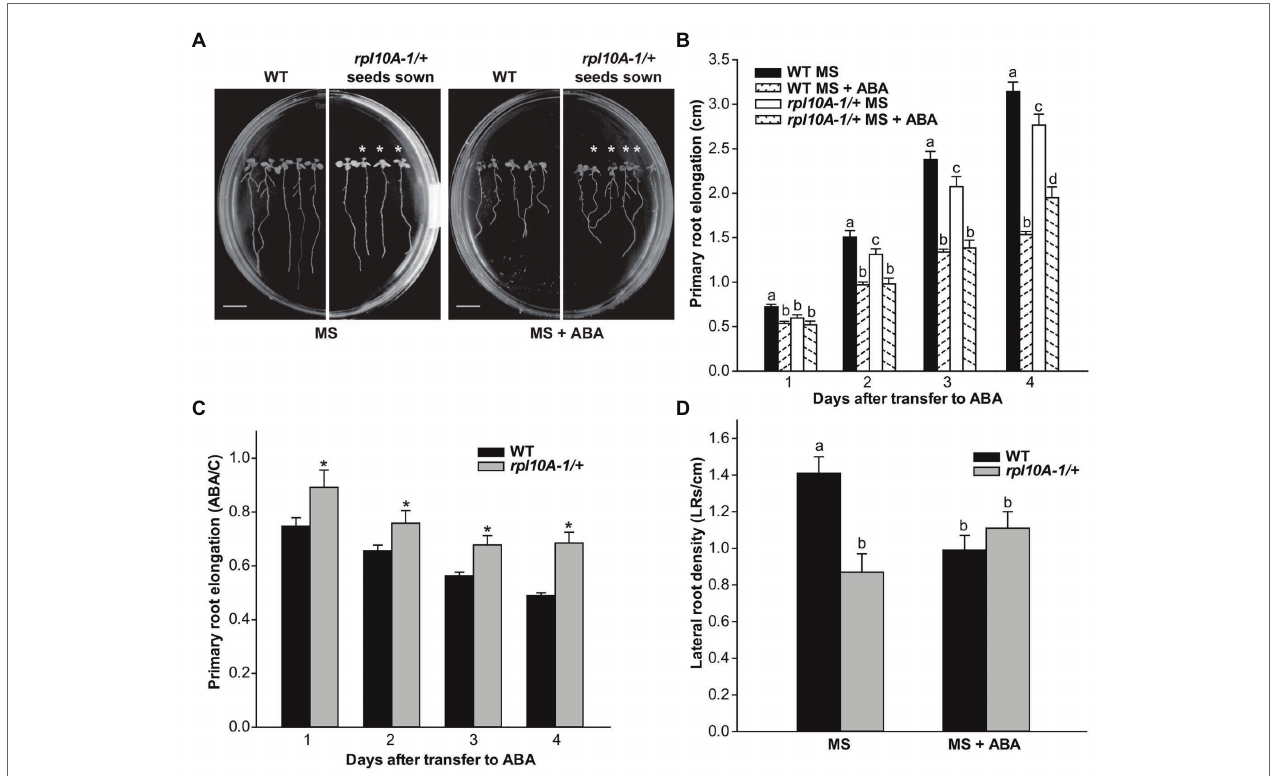
FIGURE 4 | ABA inhibition of primary root elongation and lateral root development of WT and rpl10A/+ mutant seedlings. (A) Representative images of WT and rpl10A-1/+ mutant seedlings grown on MS-agar plates and transferred to MS-agar medium (MS) or MS-agar medium supplemented with 10 μ M ABA (MS + ABA) 4 days after the transfer. Heterozygous rpl10A-1 mutant seedlings are indicated with asterisks. Bars = 1 cm. (B) Primary root elongation of WT and rpl10A-1/+ mutant seedlings measured each day after the transfer to MS-agar medium (MS) or MS-agar medium supplemented with 10 μ M ABA (MS + ABA). Results are the mean of three independent experiments ( n = 20 for each biological experiment). For each genotype and condition (MS or MS + ABA), different letters over the bars indicate statistical differences applying ANOVA test ( p < 0.05). (C) Average root length after the transfer to ABA treatment relative to control conditions (ABA/C). Asterisks indicate statistical differences between genotype at each day (Student’s t -test, p < 0.05). (D) LR density estimated as the number of LRs per root length unit of WT and rpl10A-1/+ mutants. The number of LRs was determined 4 days after the transfer of 5-day-old seedlings to plates supplemented or not with ABA. Results are the mean of three independent experiments ± SE ( n = 20 for each biological experiment). For each genotype and condition (MS or MS + ABA), different letters over the bars indicate statistical differences applying ANOVA test ( p <